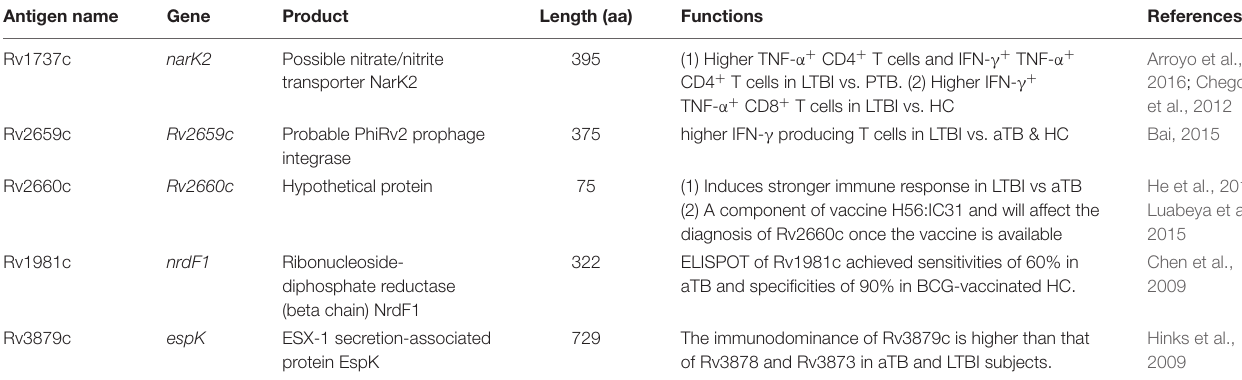
TABLE 1 | Characteristics of five selected LTBI-RD-associated